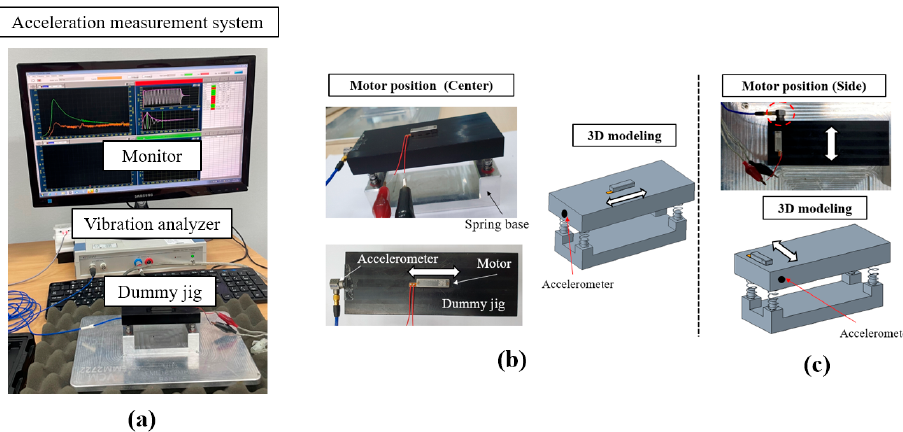
Figure 14. Acceleration measurement system: ( a ) monitor, vibration analyzer, and dummy jig; ( b ) motor position (center); and ( c ) motor position (side).